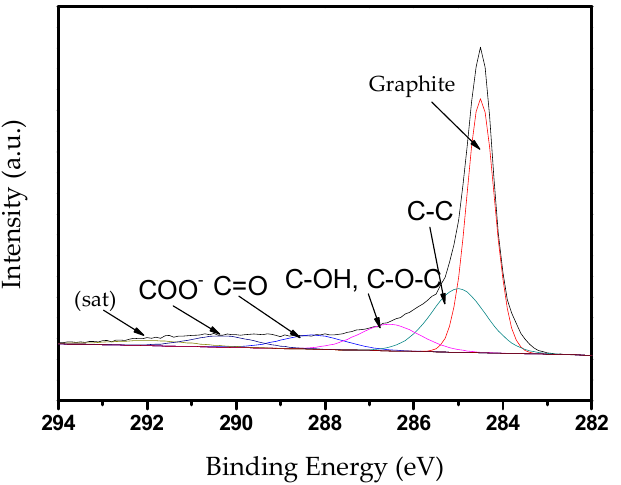
Figure 5. Ni2p XPS spectra of catalysts ( а ) 5NiS450, (b) 10NiS450, and (c) 20NiS450.